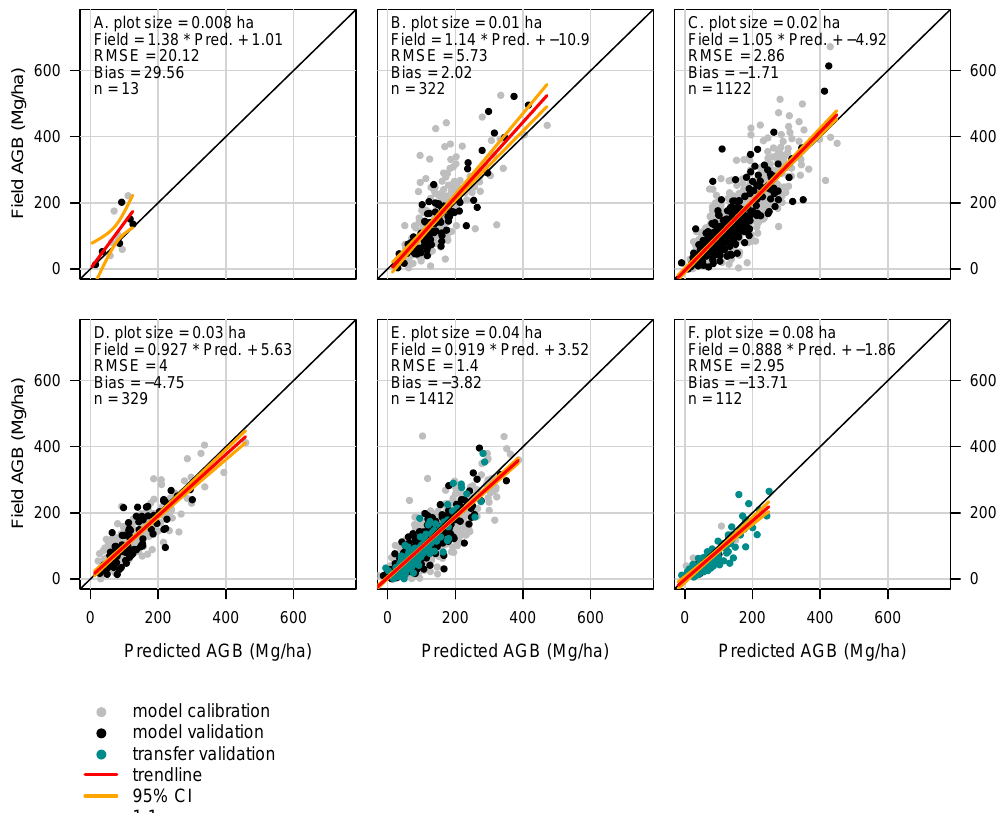
Figure 5. Scatter plot of field-measured AGB versus predicted values from the raw AGB trimmed median probability regression model (Table 6) for each of the plot sizes used in the study. Plot sizes for each window are: ( A ) 0.008 ha, ( B ) .01 ha, ( C ) 0.02 ha, ( D ) 0.03 ha, ( E ) 0.04 ha, and ( F ) 0.08 ha. Red and orange lines depict the linear fit and 95% confidence interval band of field-measured AGB versus predicted values, fit to both the model validation and transfer validation data subsets. Black line is 1:1.